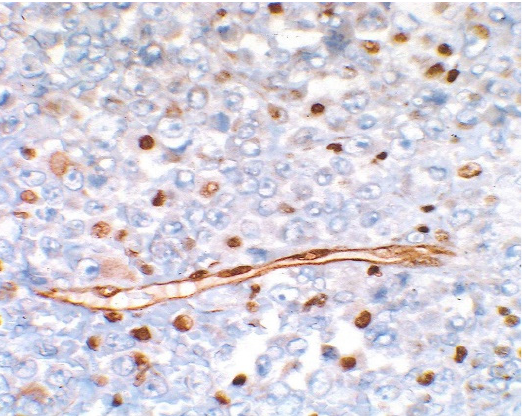
Figure 10. Loss of INI 1 immunohistochemical expression in tumor cells, ×